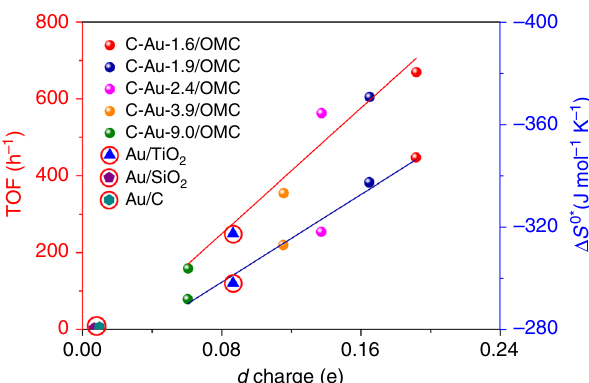
Fig. 5 Descriptor. The relationship between the d -electron gain at an Au site and the turn-over frequency (TOF, red line) and the entropy of activation ( Δ S 0 *, navy line) for the selective hydrogenation of